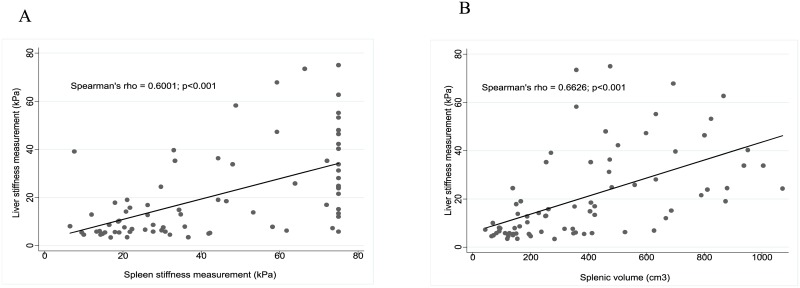
Linear correlation between liver and spleen features.Linear correlation (Sperman's rho, p value) between spleen and liver stiffness measurement (A) and between splenic volume and liver stiffness measurement (B).